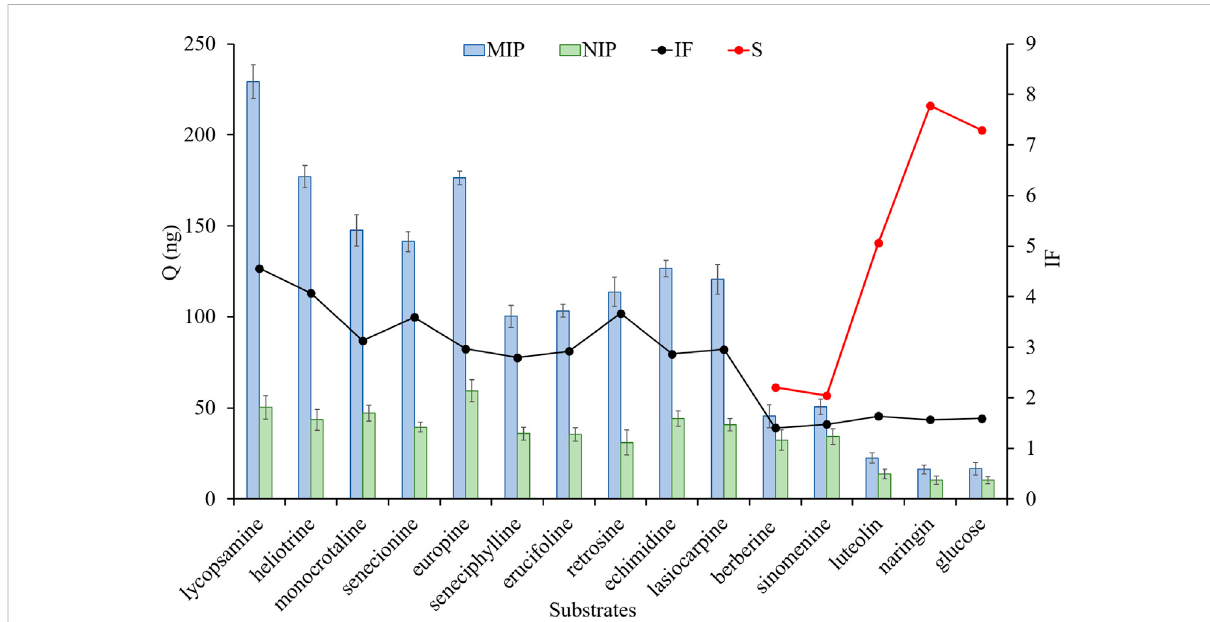
FIGURE 4 The adsorption capacity, imprinted factor and selectivity coef fi cient of different fi bers for different substrates. The adsorbed solution was a mixture and was contained with 15 types of compounds, including lycopasmine, heliotrine, monocrotaline, senecionine, europine, seneciphylline, erucifoline, retrosine, echimidine, lasiocarpine, berberine, sinomenine, luteolin, naringin and glucose. The concentration of each compound was 400 ng · mL − 1 .